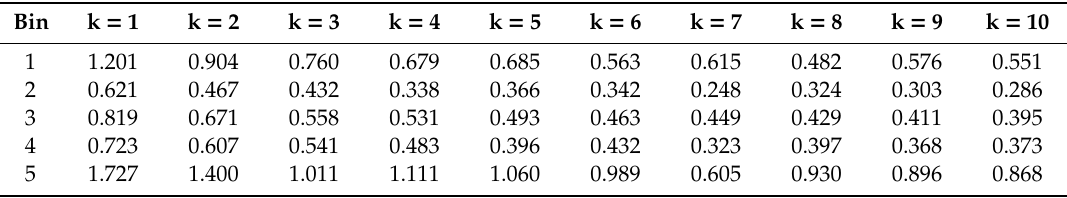
Table 8. MAE for CAISO